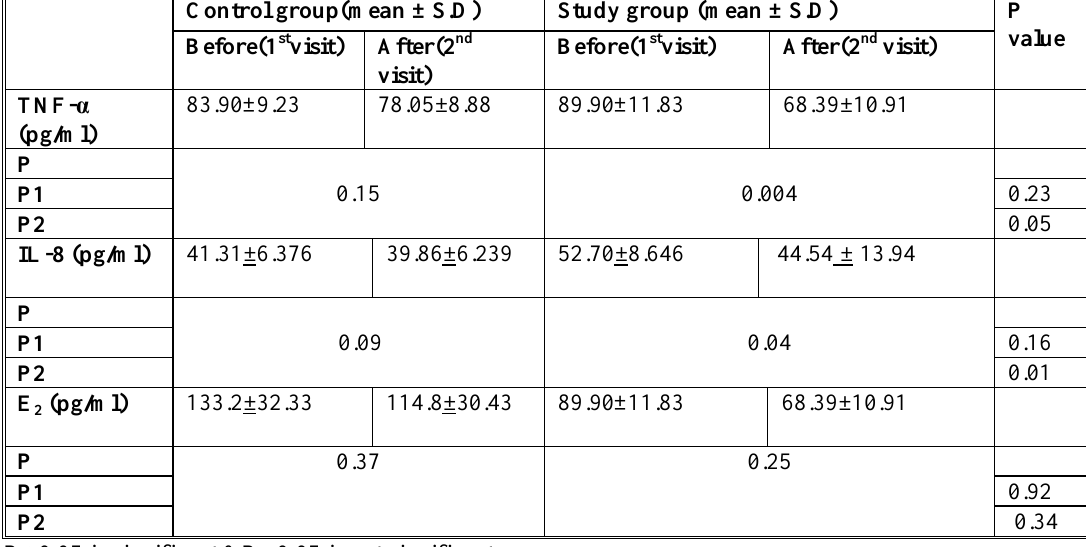
Table (8): Tumor necrosis factor-alpha (TNF- α), Interlukin-8(IL-8) and Estradiol (E the control and study